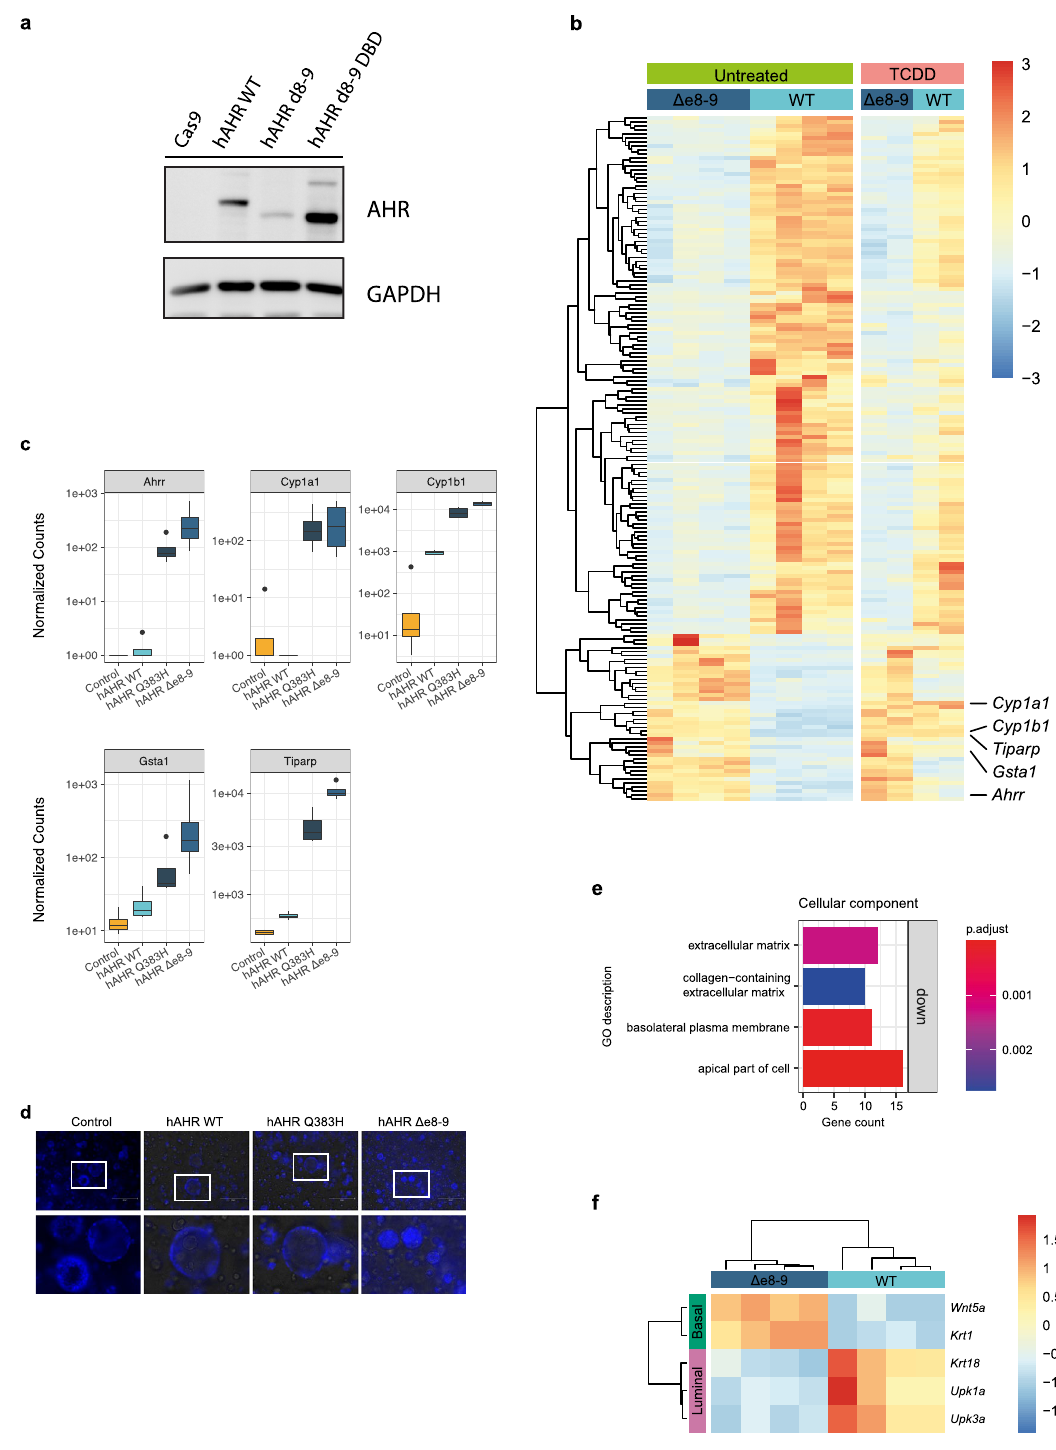
Figure 3. Transcriptome analysis of constitutively activated hAHR Δe8-9 mutant. ( a ) Western blot results for transgenic mouse cell lines, expressing Cas9 (negative control), hAHR WT, hAHR Δe8-9 , or a DNA-binding deficient version of hAHR Δe8-9 (hAHR Δe8-9 DBD ). ( b ) Rlog values of the 172 most differentially expressed genes between the hAHR WT and hAHR Δe8-9 transgenic mouse bladder organoids in untreated and TCDD treated conditions. ( c ) Boxplot of normalized counts of RNA reads of AHR target genes for the untreated mouse bladder organoids expressing hAHR mutants (n = 4). ( d ) Images of Dapi stained mouse bladder organoids constitutively expressing hAHR mutants. The lower panel shows the magnification of the boxed area. Scale bar 250 µm. ( e ) GO enrichment analysis of hAHR Δe8-9 mutant for the cellular component domain. ( f ) Rlog values of basal and luminal cell layer makers for hAHR Δe8-9 and hAHR WT transgenic mouse bladder